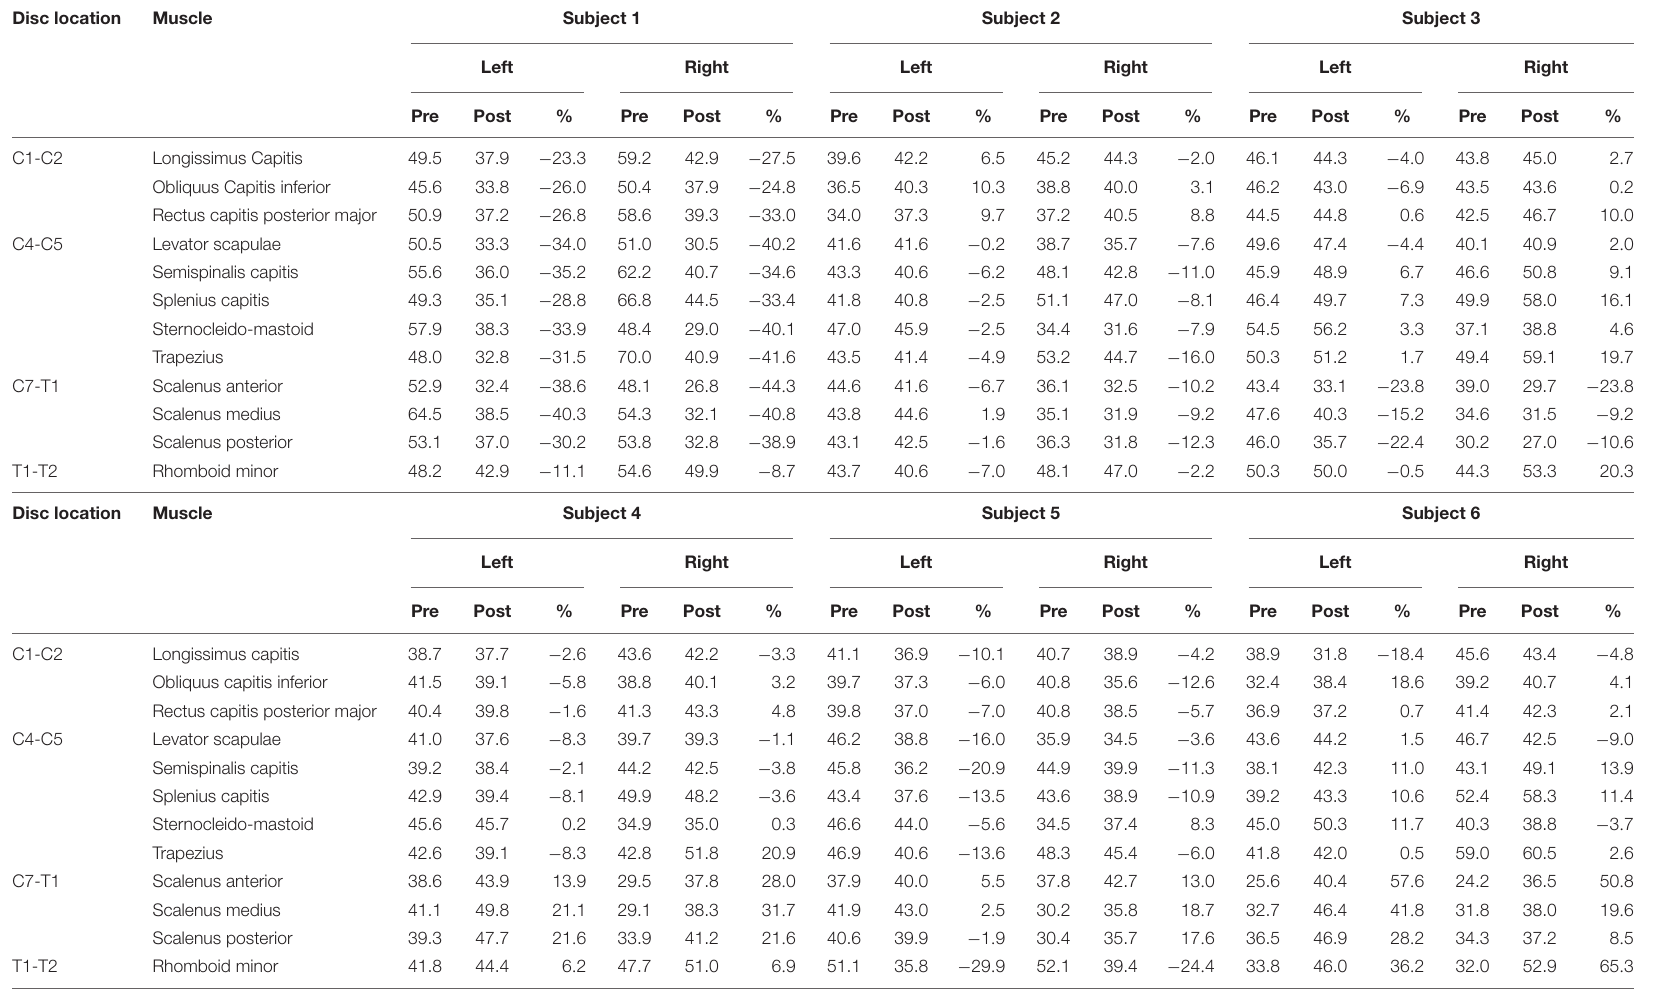
TABLE 3 | Absolute and percent changes in muscle fat infiltration (MFI) for the six crewmembers (Subject 1–Subject